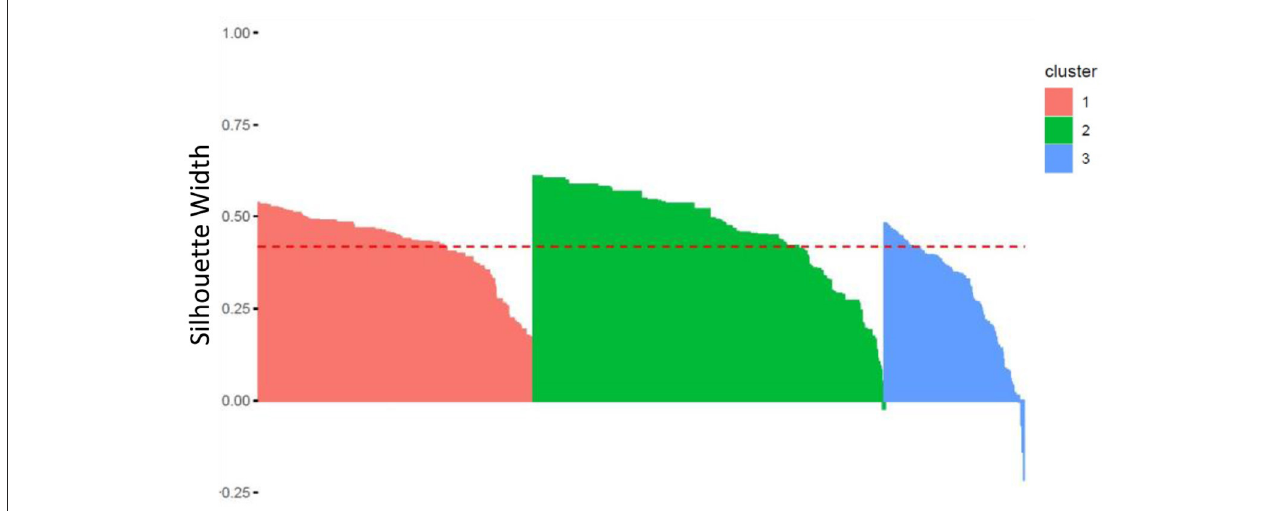
FIGURE6 Silhouette Width for each patient within each of the three clusters (the red line corresponds to the Average Silhouette